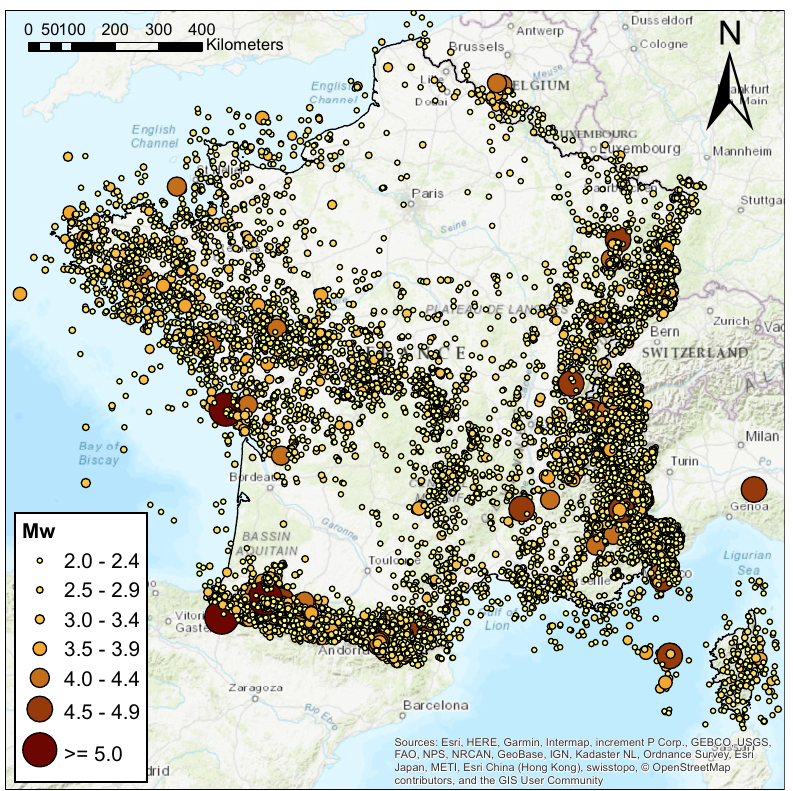
Figure 5. SIHex and ReNaSS catalogues (1965–2020) used in this study to calculate the FMD of main shocks for the whole of mainland France. Only the 15,567 earthquakes with magnitudes greater than or equal to 2 are